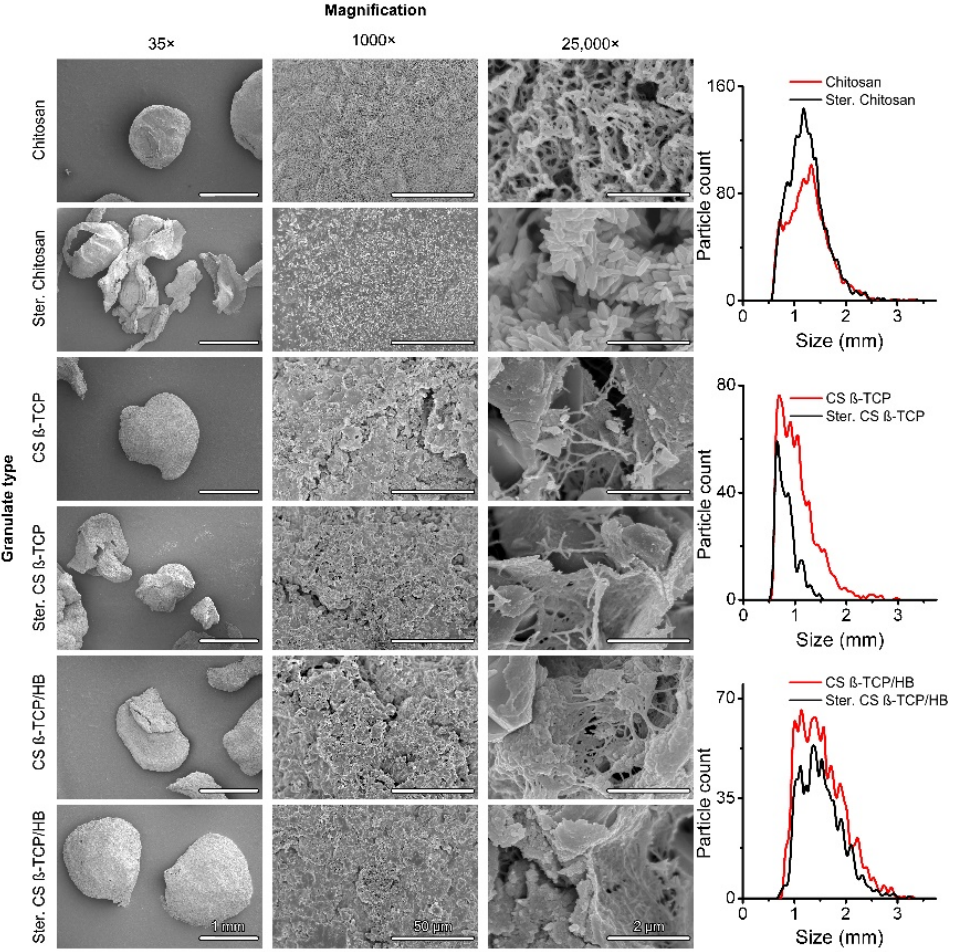
Figure 2. SEM images and size distributions of prepared granulates. The size of particles is understood as the diameter of a sphere, in which cross-section area equals the area of the object determined with digital image analysis.